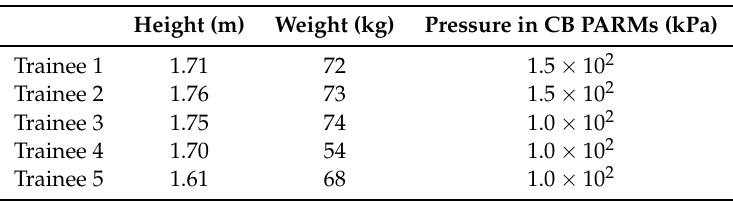
Table 4. Parameters of the